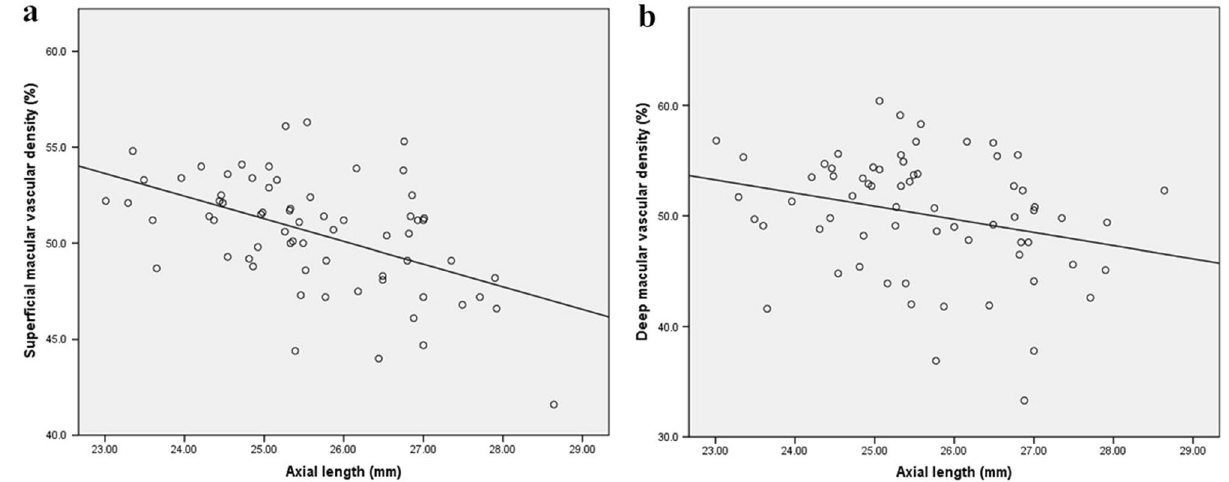
Figure 1. Scatter plots showing negative correlation between axial length and superficial and deep macular vascular density ( a ) superficial and ( b ) deep macular vascular